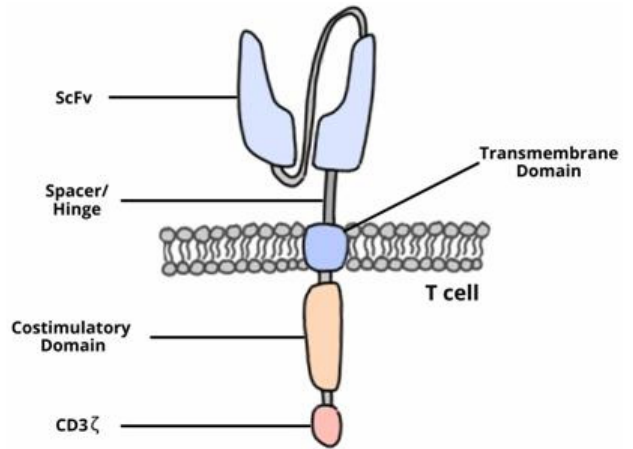
Figure 1. The CAR-T structure is composed of ScFv: This region enables the T cell to recognize the target antigen; hinge or spacer: binds the ScFv to the transmembrane domain and contributes to ScFv flexibility; transmembrane domain: the link between the extracellular and intracellular regions; CD3z: an intracellular signaling domain that activates the T cell; and costimulatory molecules: involved in improving CAR-T proliferation and persistence.